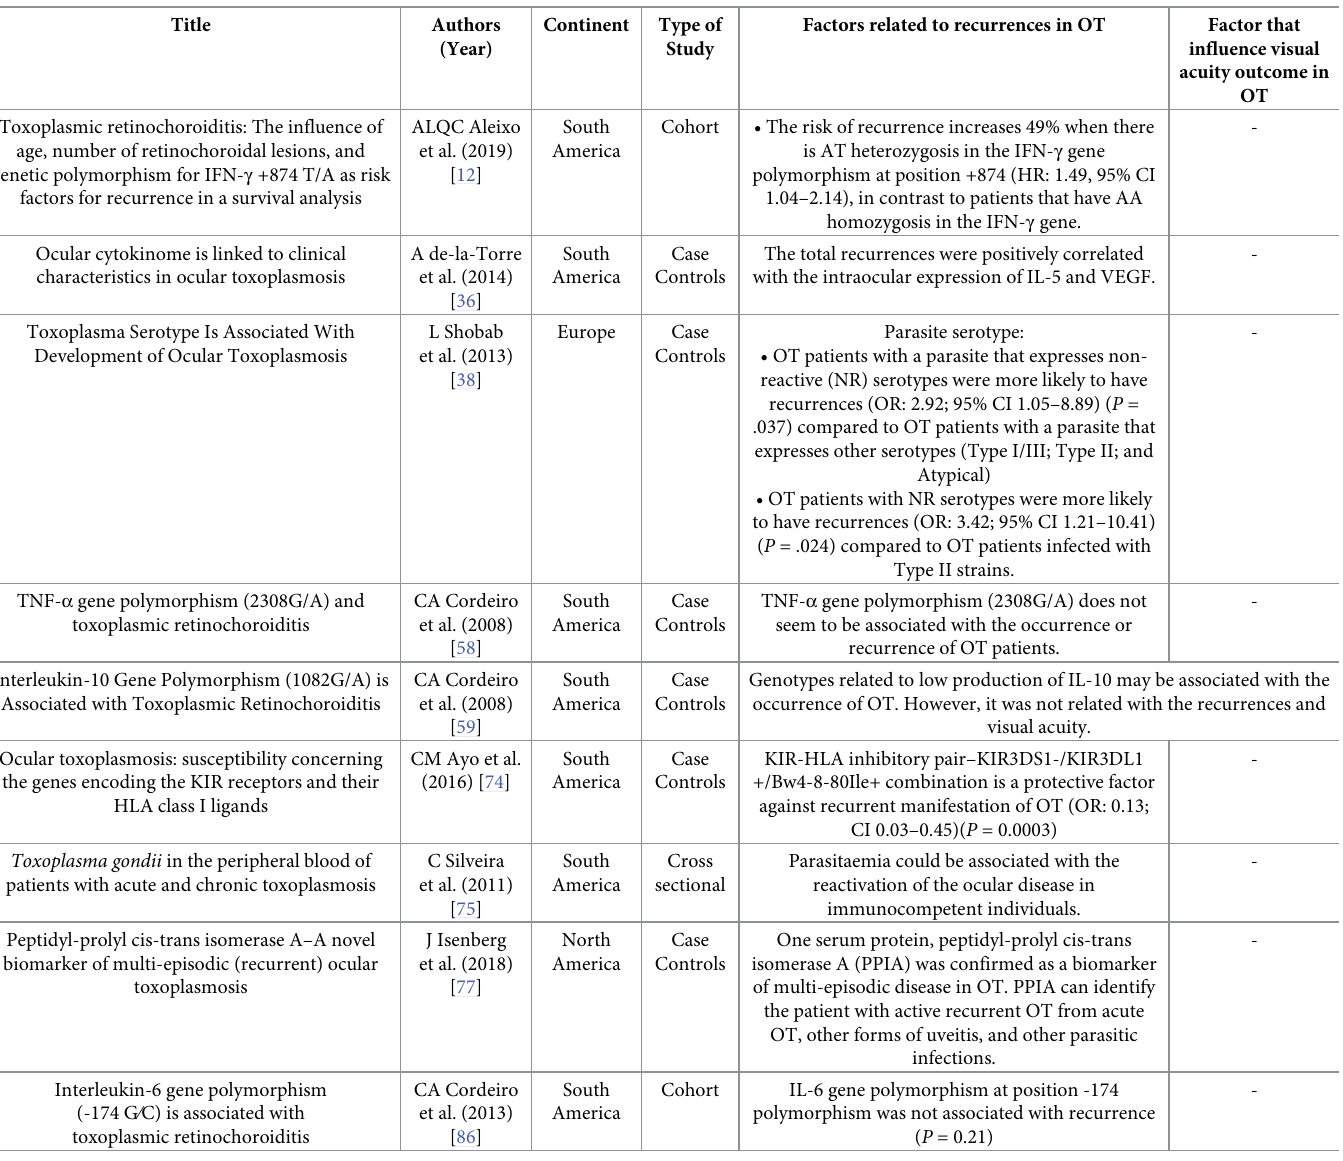
Table 2. Host and parasite factors related to recurrences and visual